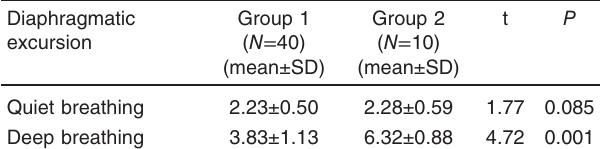
Table 3 Staging of patients with chronic obstructive pulmonary disease according to severity Stage GOLD stage I